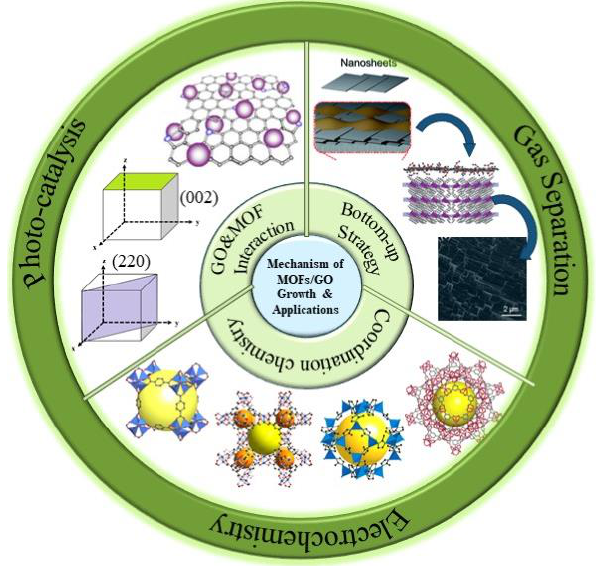
Figure 1. Schematic diagram of factors affecting the growth of metal-organic framework (MOF) in the presence of graphene oxide (GO) and the applications of oriented MOF/GO nanocomposites.